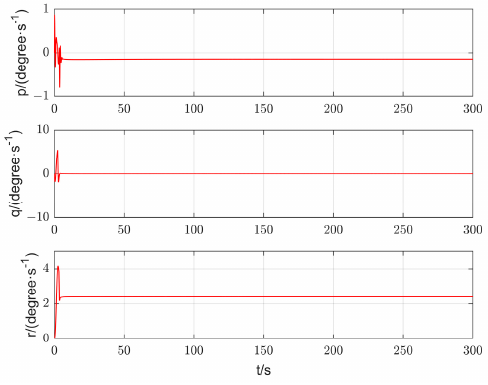
Figure 15. Angular velocity curves with FOPID.